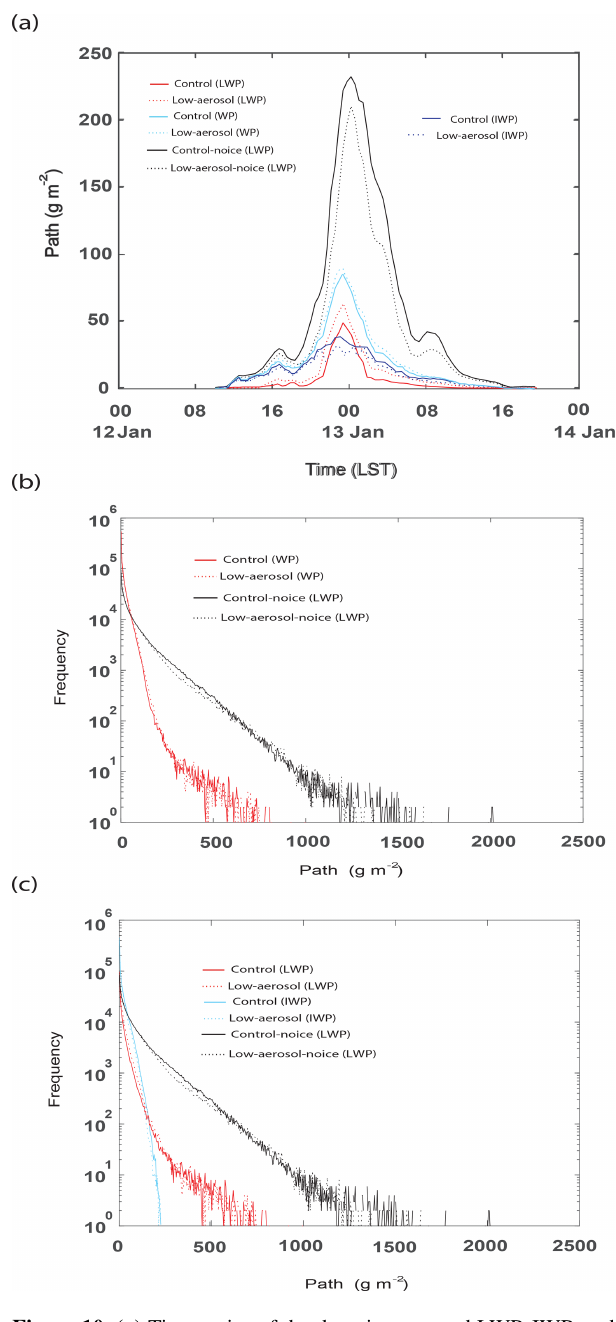
Figure 10. (a) Time series of the domain-averaged LWP, IWP, and WP for the control and low-aerosol runs and LWP, which is also WP, for the control-noice and low-aerosol-noice runs. (b) Cumulative frequency of WP for the control, low-aerosol, control-noice, and low-aerosol-noice runs, and (c) LWP and IWP for the control and low-aerosol runs and LWP in the control-noice and low-aerosol- noice runs at the last time